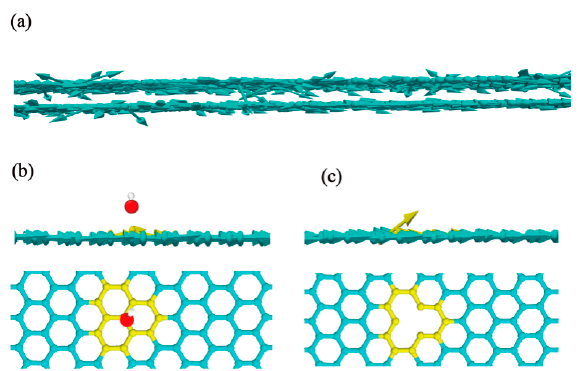
Figure 7. Spatial distribution of heat flux by vector arrows on each atom under nonequilibrium steady state. ( a ) The overlapping structure of GO ( b ) a hydroxyl group, and ( c ) a single vacancy defect.